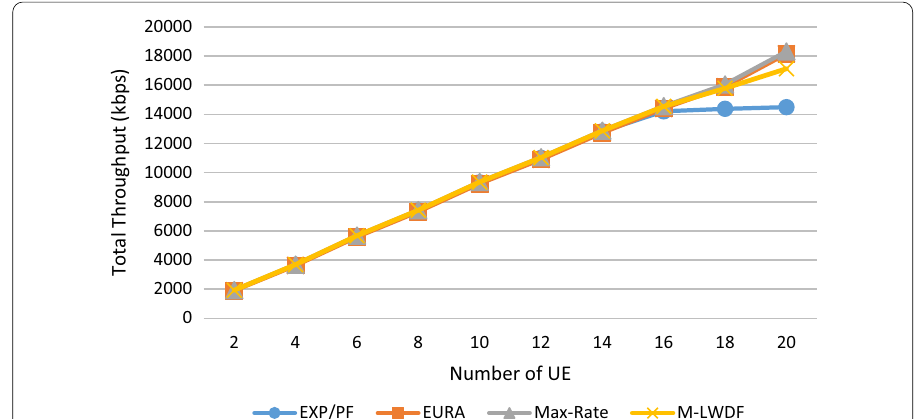
Fig. 14 Simulation result of total throughput; The performance comparison of total throughput for our proposed scheme and the contrasts